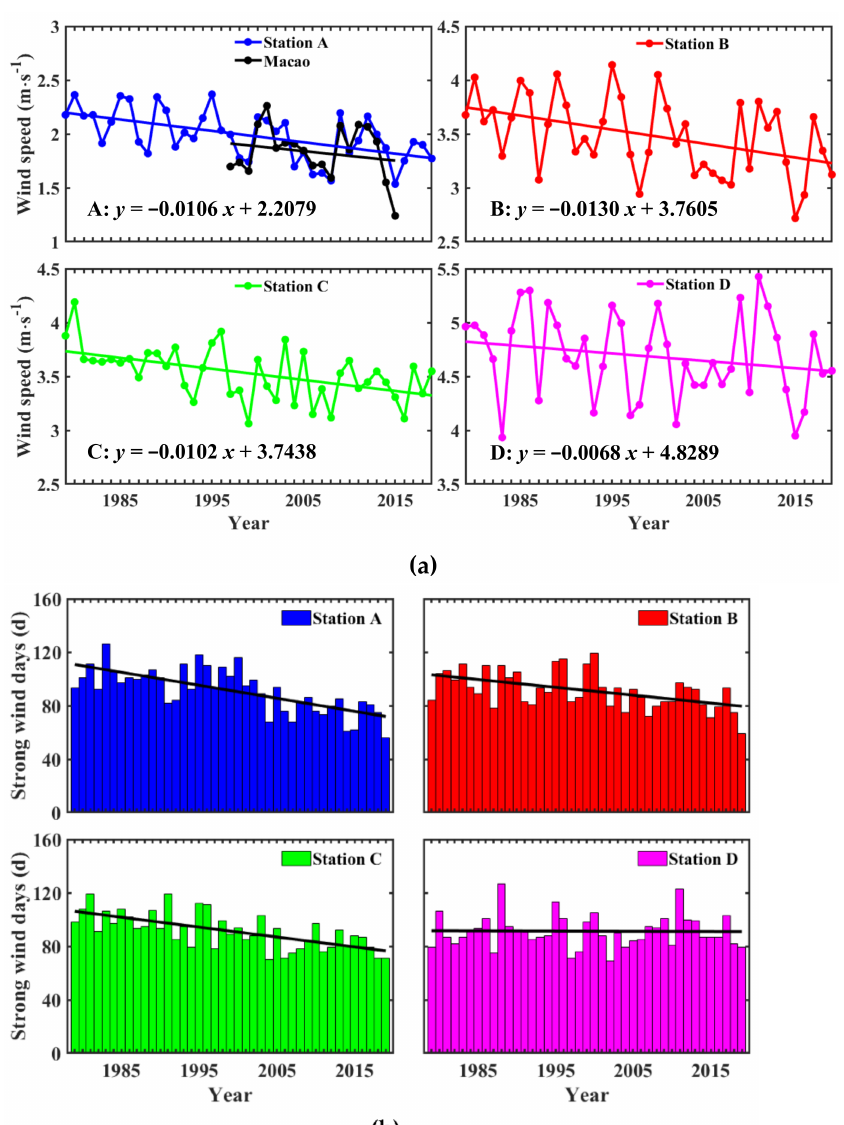
Figure 5. Trends of annual mean wind speed ( a ) and strong wind days ( b ) at station A, B, C and D, respectively, from 1979 to 2019. The annual mean wind speed and corresponding trend obtained from ERA5 data at station A were compared with the data obtained from the adjacent Macau Airport (from 1997 to